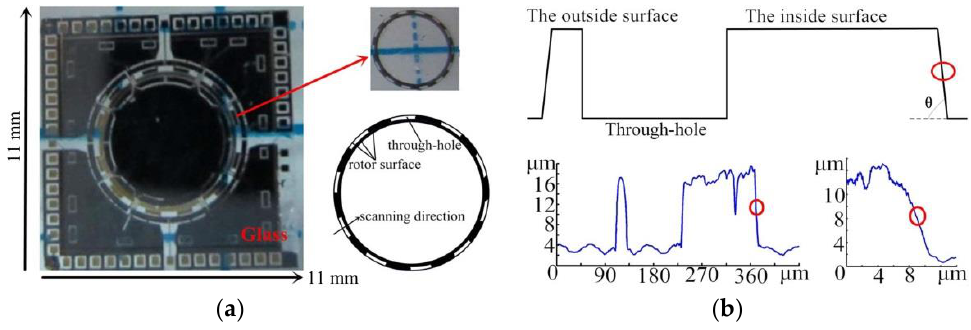
Figure 20. ( a ) Physical maps of the micro-gyroscope and the rotor. ( b ) Measurement results of the lateral scanning. (Figure reproduced from Ref. [82]).